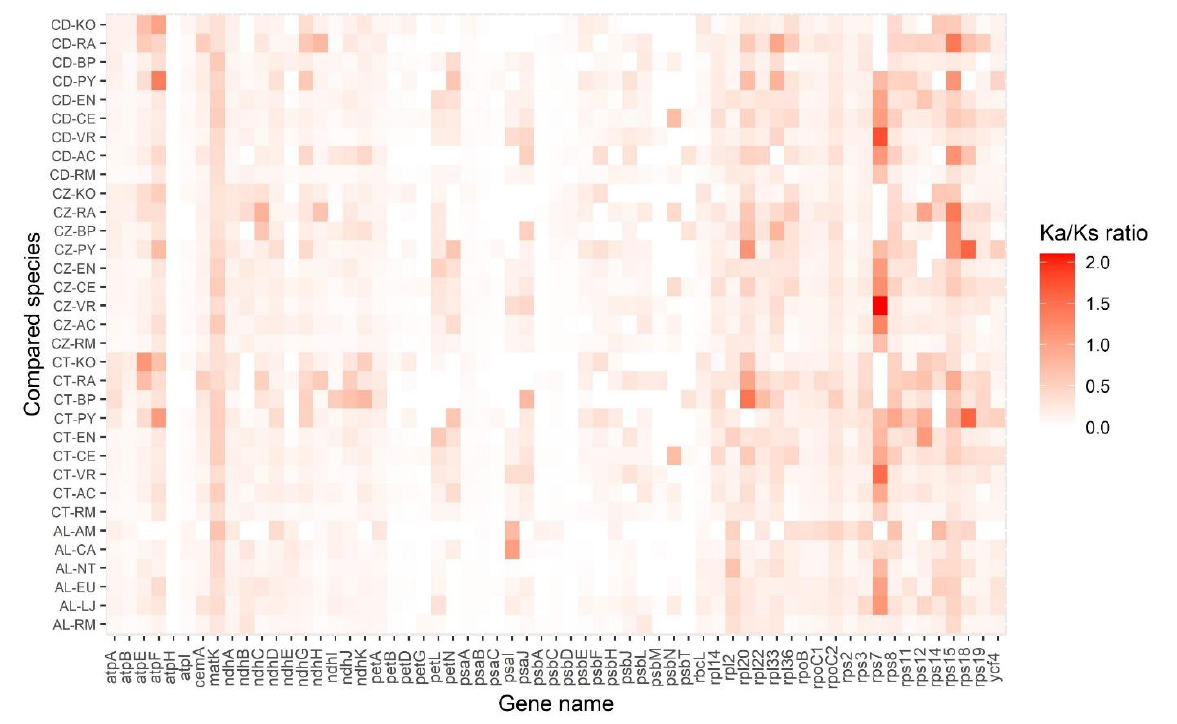
Figure 7. Heatmap of Ka/Ks ratios between every compared species in 61 chloroplast genes. The scale ratios associated with each value are shown in the key beside the figure. AL ( Avicennia lanata ), AM ( Avicennia marina ), CA ( Coffea arabica ), EU ( Eucommia ulmoides ), LJ ( Lonicera japonica ), NT ( Nicotiana tabacum ), RM ( Ranunculus macranthus ), CD ( Ceriops decandra ), CZ ( Ceriops zippeliana ), CT ( Ceriops tagal ), AC ( Averrhoa carambola ), BP ( Bruguiera parviflora) , CE ( Ctenolophon englerianus) , EN ( Erythroxylum novogranatense ), KO ( Kandelia obovata ), PY ( Pellacalyx yunnanensis ), and RA ( Rhizophora apiculata